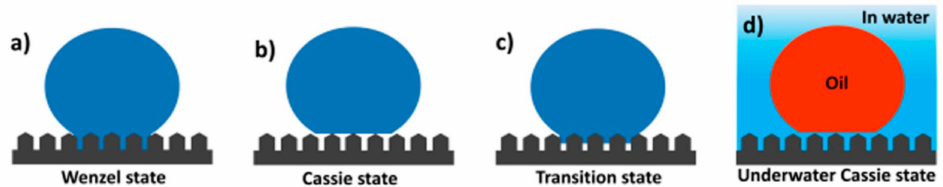
Figure 7. Four types of contact models of a droplet on solid substrates. ( a – c ) Liquid droplet on the rough surface at di ff erent wetting states: ( a ) Wenzel state; ( b ) Cassie state; ( c ) transition state; and ( d ) underwater Cassie state—oil droplet on the hydrophilic rough surface in